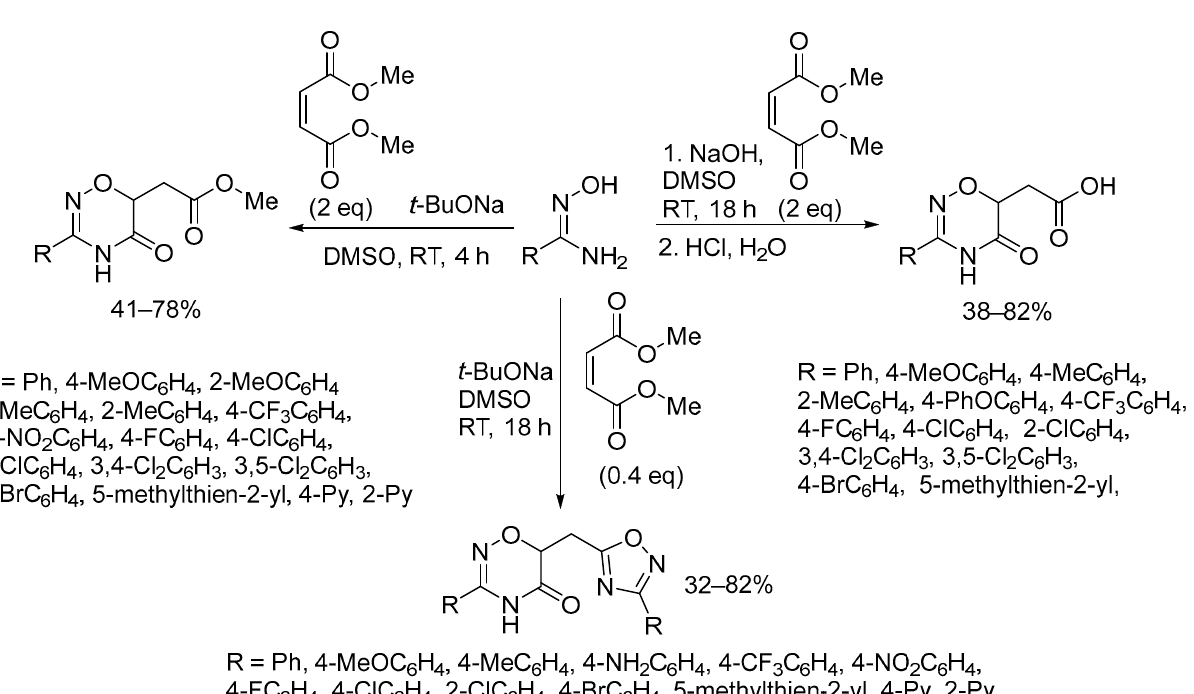
Scheme 17. Synthesis of 1,2,4-oxadiazin-5(6 H )-ones from amidoximes and maleic dimethyl ester. Carbonyldiimidazole (CDI) was found to be the appropriate activating agent for the synthesis of 1,2,4-oxadiazoles from amidoximes and carboxylic acids in the NaOH/DMSO medium [97]. Ethyl and isobutyl chloroformates in combination with organic bases (TEA or pyridine) also can be used instead of CDI; however, the yield of 1,2,4-oxadiazoles will be less. The reaction scope was demonstrated by 26 different examples (Scheme 18). This protocol was used by Arifuddin et al. for the preparation of coumarins bearing the 1,2,4-oxadiazole moiety as selective inhibitors of cancer-related h CA IX and XII isoforms [113].